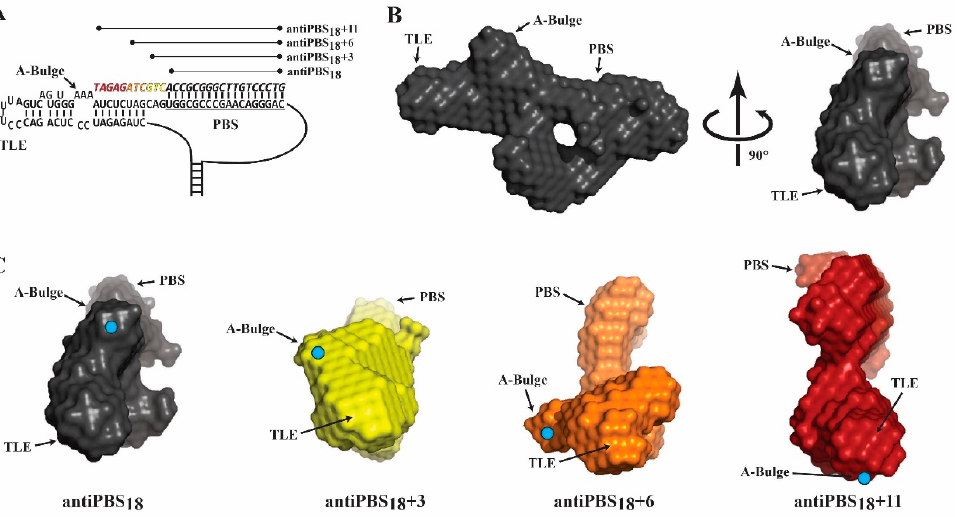
Figure 5. SAXS analysis of extended primer complexes. ( A ) Schematic of construct design for annealing of extended DNA primers (italic font) designed to disrupt the structure of the TLE stem. ( B ) SAXS-derived molecular envelope of the antiPBS 18 -annealed PBS/TLE construct. ( C ) SAXS- derived molecular envelopes for the PBS/TLE RNA with DNA primers of different lengths annealed. When aligned using the PBS loop as a reference, the location of the A-Bulge (cyan dot) rotates counterclockwise about the structure. Equilibrium dissociation constants (K d ) for human WT LysRS( ∆ N65) and S207D LysRS( ∆ N65) binding PBS/TLE 105 :antiPBS complexes. RNA-DNA Complex